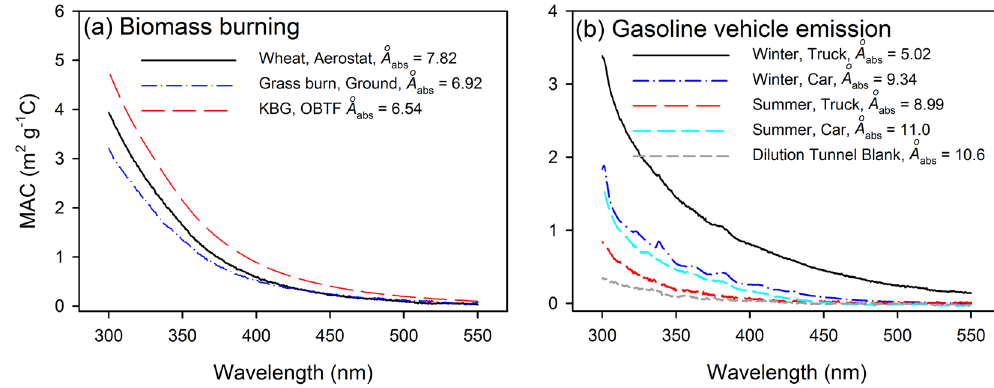
Figure 1. Representative MAC spectra for PM 2.5 samples from ( a ) Biomass burning and ( b ) gasoline vehicle emissions.